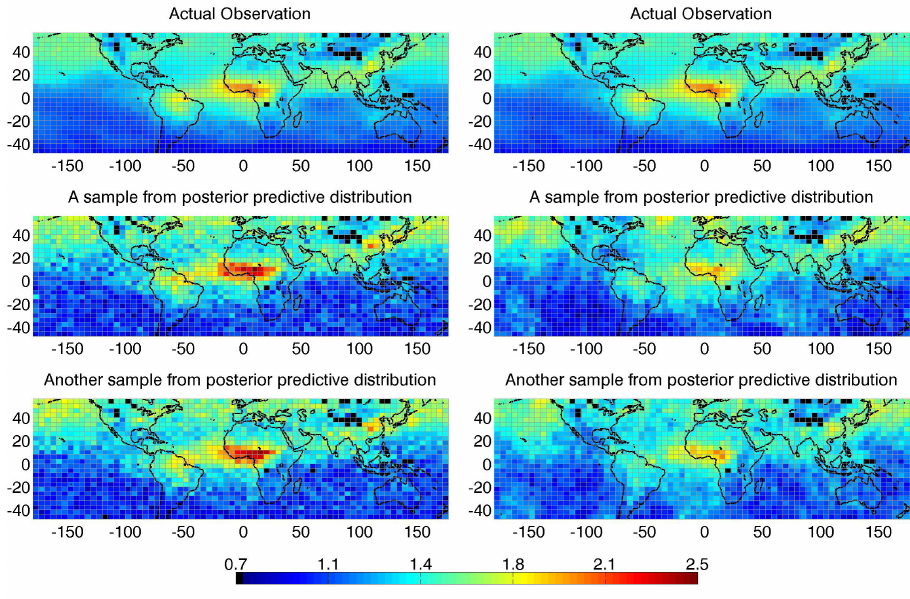
Fig. 13. Two samples of column CO fields (in units of 10 18 moleculesCOcm − 2 ) from the posterior predictive distributions of NS (lower 2 plots, left panels) and CAR (lower 2 plots, right panels) models for December 2000; the top panels show the corresponding MOPITT retrieval